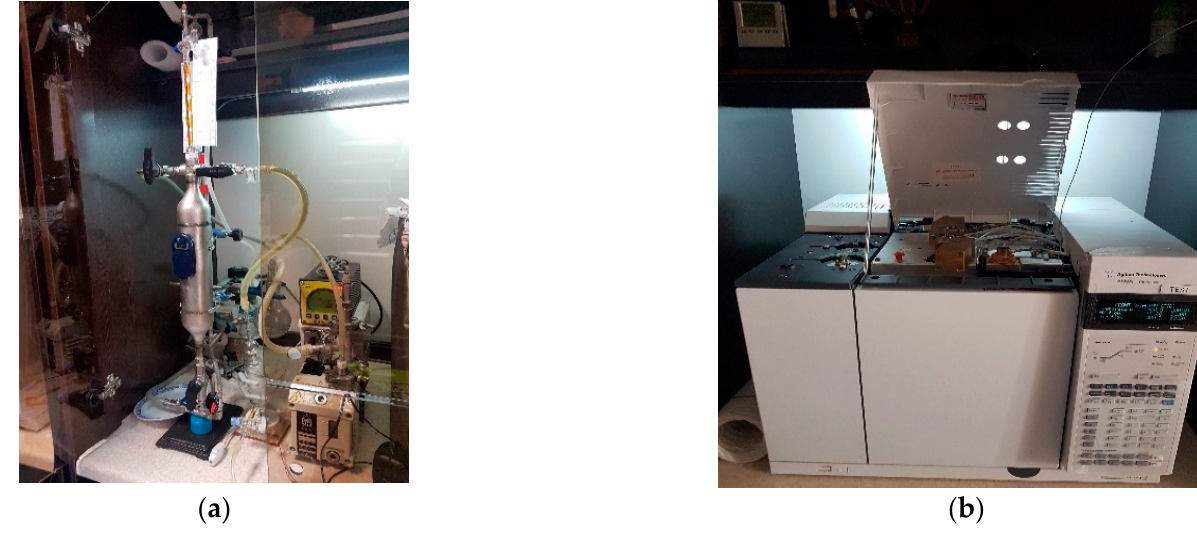
Figure 4. ( a ) Extraction of oil-soluble gases by vacuum; ( b ) Gas chromatography test set-up.